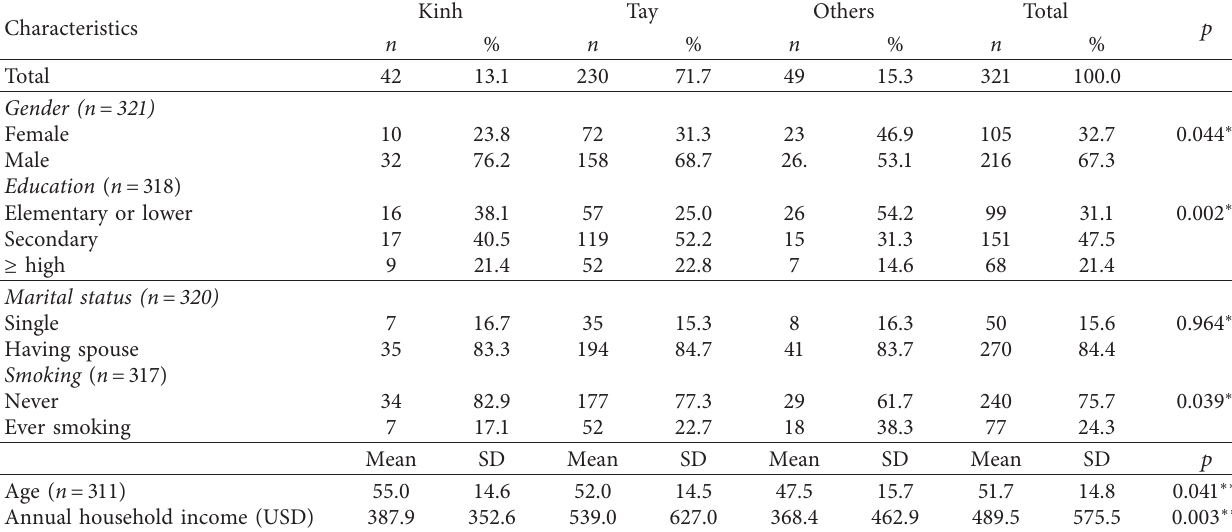
Table 1: Demographic characteristics by ethnic